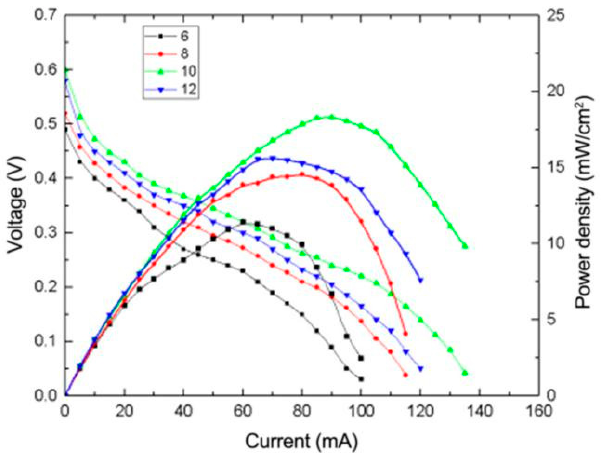
Figure 3. Effect of different pH values during the reduction process on micro direct methanol fuel cell ( μ DMFC) performance. cell ( µ DMFC) performance.